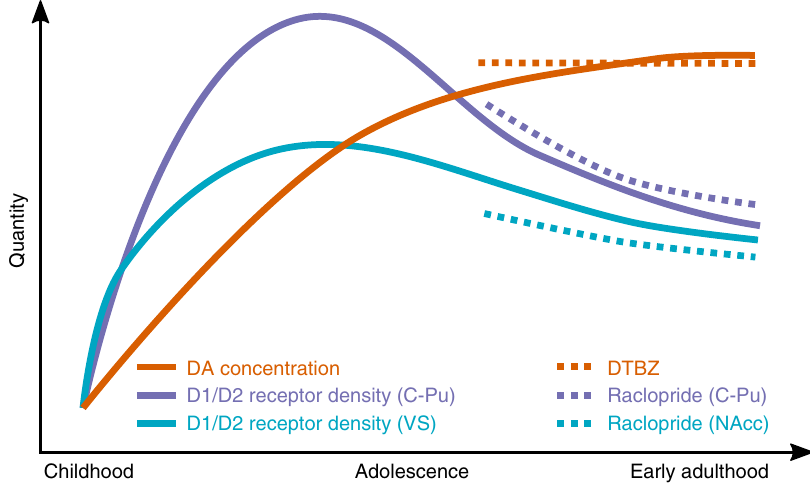
Fig. 3 Schematic depiction of PET imaging results and prior work from rodent models of dopamine system development in the striatum. Results from the present study are indicated in dashed lines, and schematic representations of age trajectories from developmental rodent models are depicted in solid lines. DA dopamine; DTBZ [11C]Dihydrotetrabenazine binding potential, Raclopride [11C]Raclopride binding potential; C-Pu caudate-putamen; VS ventral striatum; NAcc nucleus